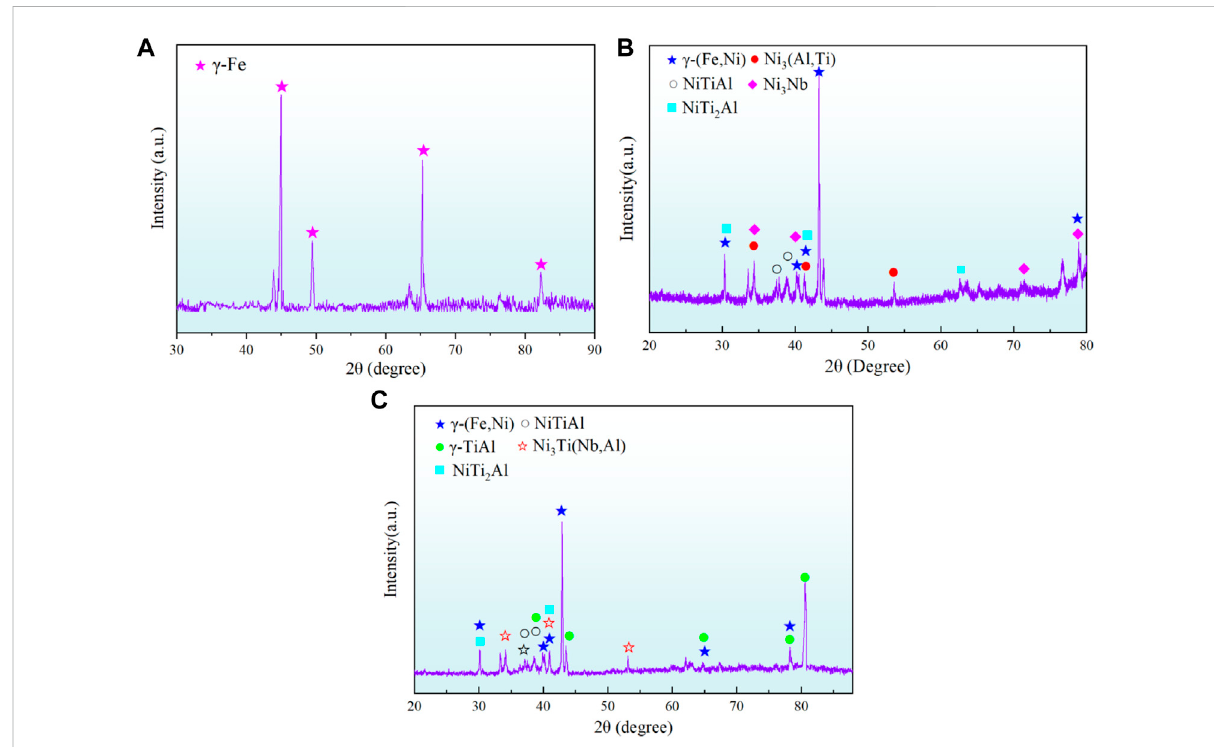
FIGURE 5 XRD pattern of (A) 316-based reaction layer, (B) intermediate layer and (C) TiAl-based reaction